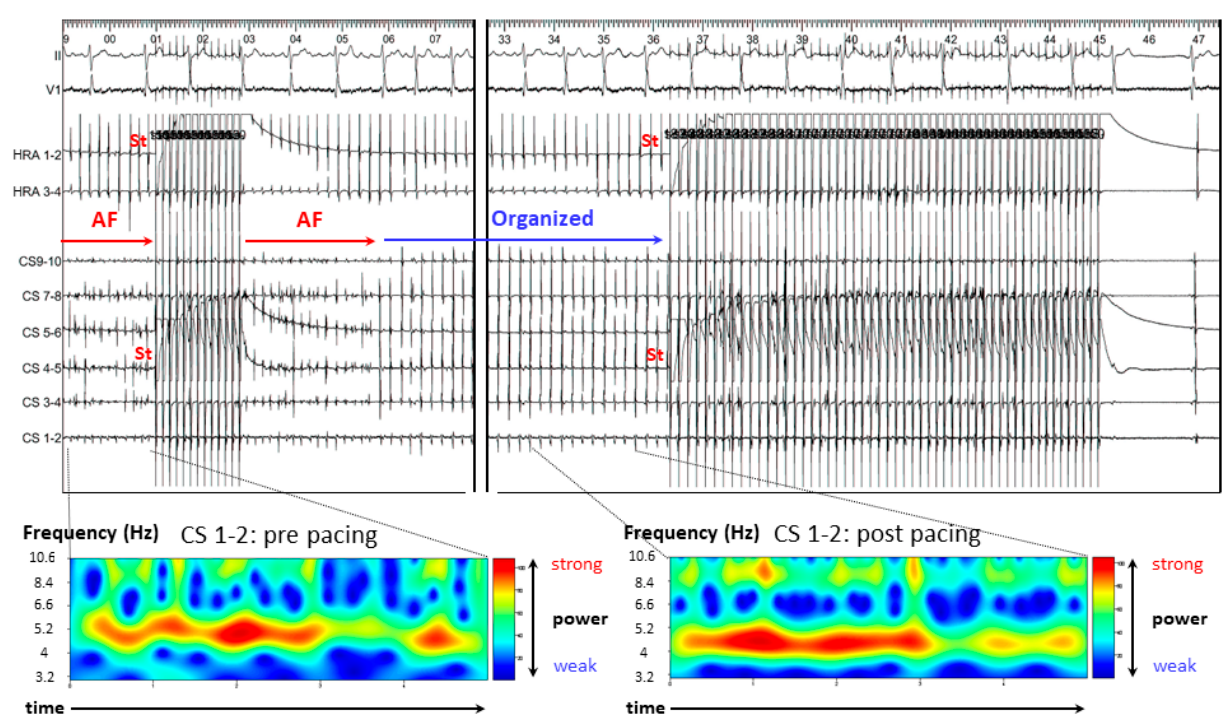
Figure 4. Case 3. AF resulted in organized tachycardia after simultaneous A-ATP from CS and HRA and terminated directly by decremental pacing. In the continuous wavelet transform analysis, red line prolonged after A-ATP. AF = atrial fibrillation; CS = coronary sinus; PAF = paroxysmal AF; HRA = high right atrium; St = stimulation.